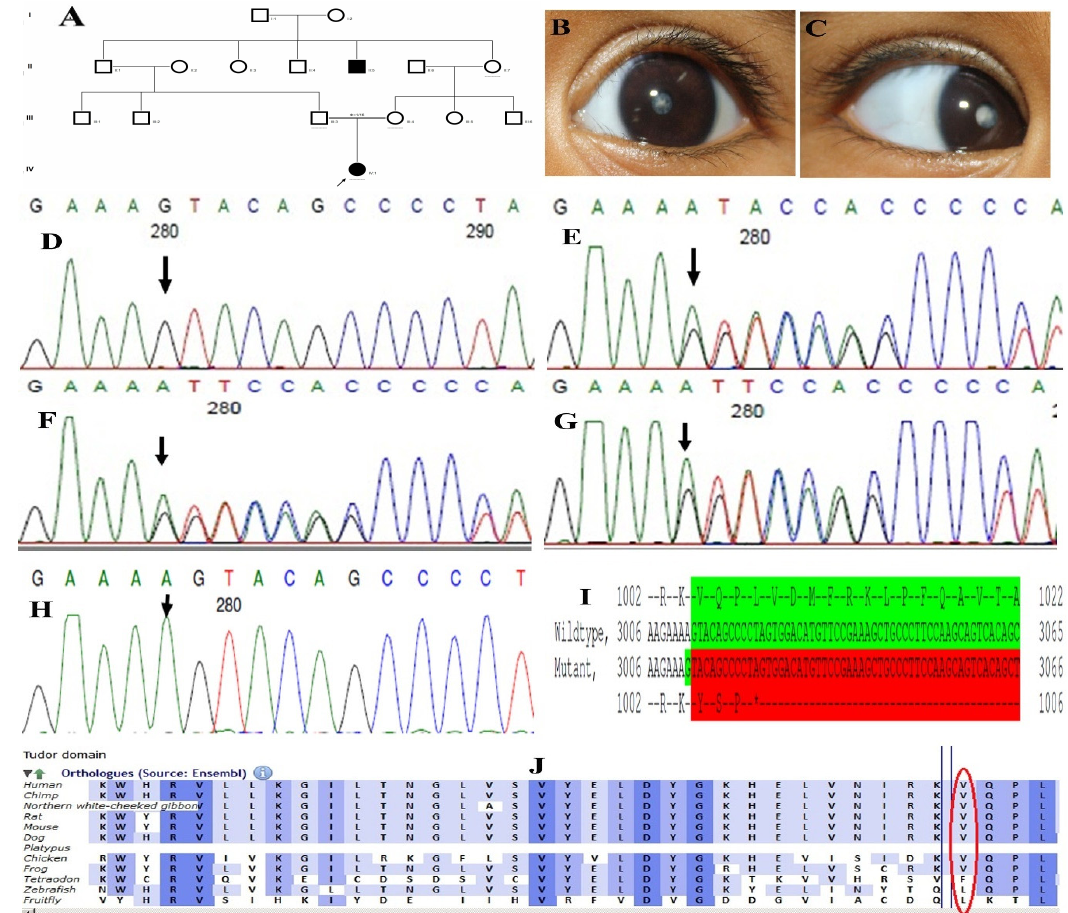
Figure 1. The pedigree of DKEC4 ( A ). Eye picture of the proband’s (IV:1) right eye ( B ) and left eye ( C ) depicting posterior subcapsular cataracts. Partial sequence chromatogram of the DKEC4 family members, TDRD7 exon 16, depicting a homozygous mutation (c.3012 del; p.Val1005Tyrfs*4) in the proband (( D )—IV:1). Other family members: mother (( E )—III:4), father (( F )—III:3) and grandmother (( G )—II:7) were heterozygous for this variant control subject ( H ), showing a wildtype sequence. Site of mutation marked by an arrow. Mutational consequence leading to frame shift (in red) compared with wildtype sequence (in green) ( I ). Amino acid sequence alignment of human TDRD7 and orthologs from other species, showing a conservation of p.V10005 (encircled in red) ( J ). Divergent amino acid residues are shaded in a white color background.